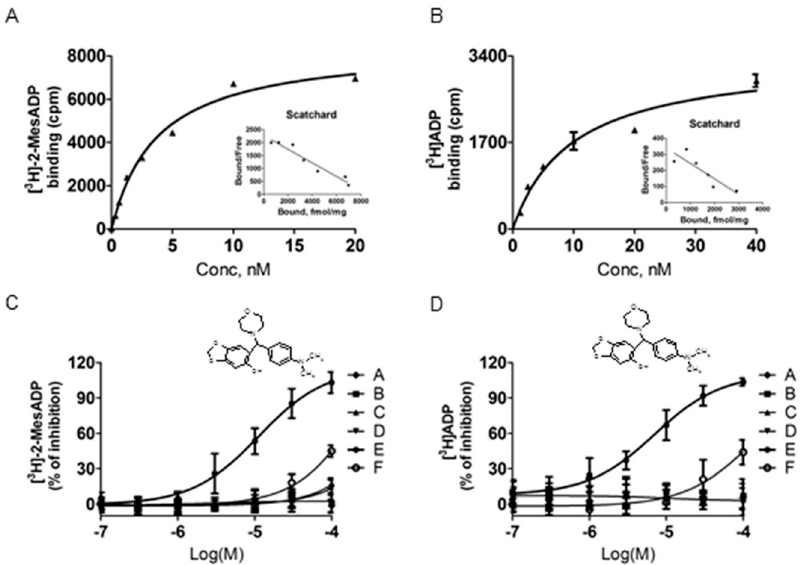
Figure 3. Binding characteristics of rhP2Y12. Saturation curves and Scatchard plots of ( A ) [ 3 H]-2-